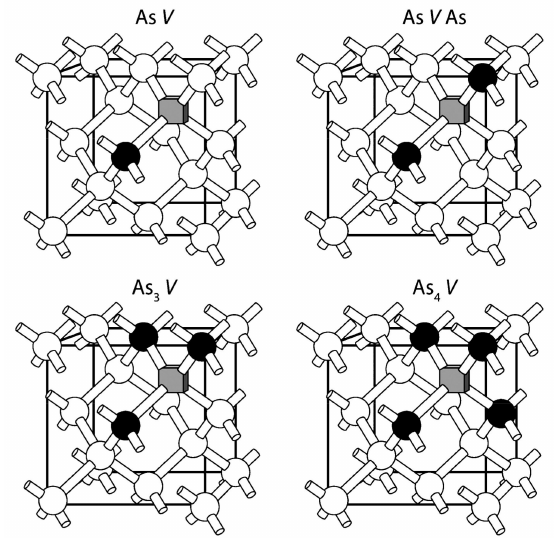
Figure 6. Schematic representation of the As n V clusters in Ge. Cubes represent the vacancies, black circles represent the As atoms, and white circles represent the Ge atoms. Reproduced with permission from [8]. American Institute of Physics,